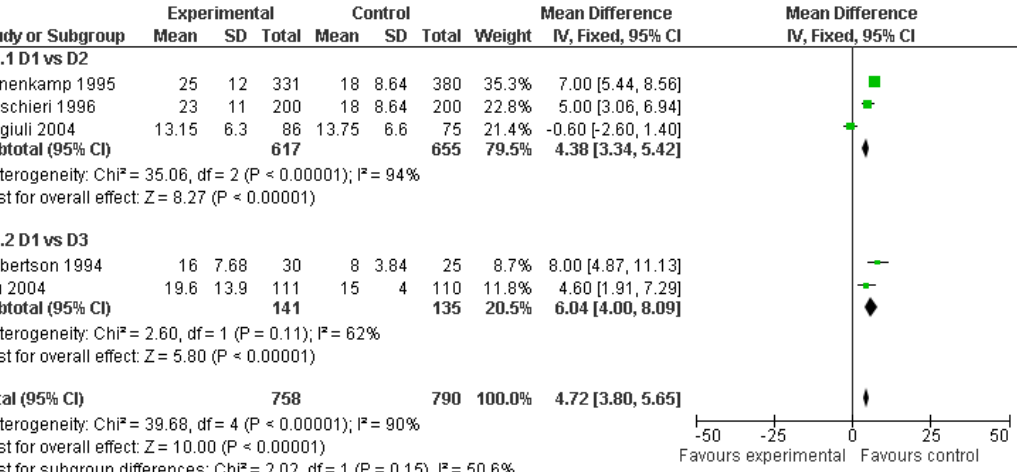
FIGURE 5 – Meta-analysis of hospital stay (days). Effects estimates (odds ratio; 95% CI). Pooled treatment effect is shown as a diamond that spans the 95% CI. Significant statistical heterogeneity between studies results. Overall effect with statistically significant difference between D1 and D2 or D3 lymphadenectomy favoring D1 (p=0.00001)